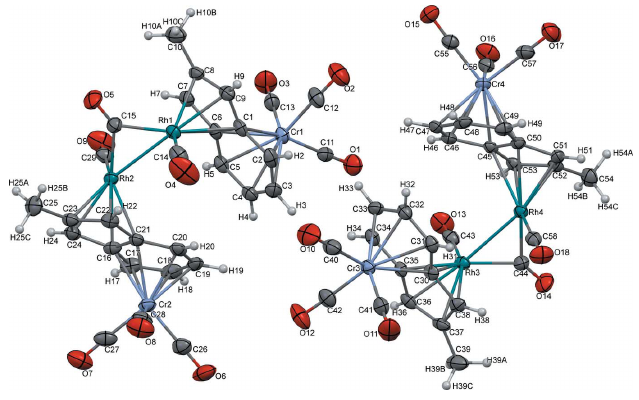
Figure 2 The asymmetric unit of 3 with displacement ellipsoid at the 30% probability level, showing the two independent molecules, i.e. 3a (left) and 3b (right).